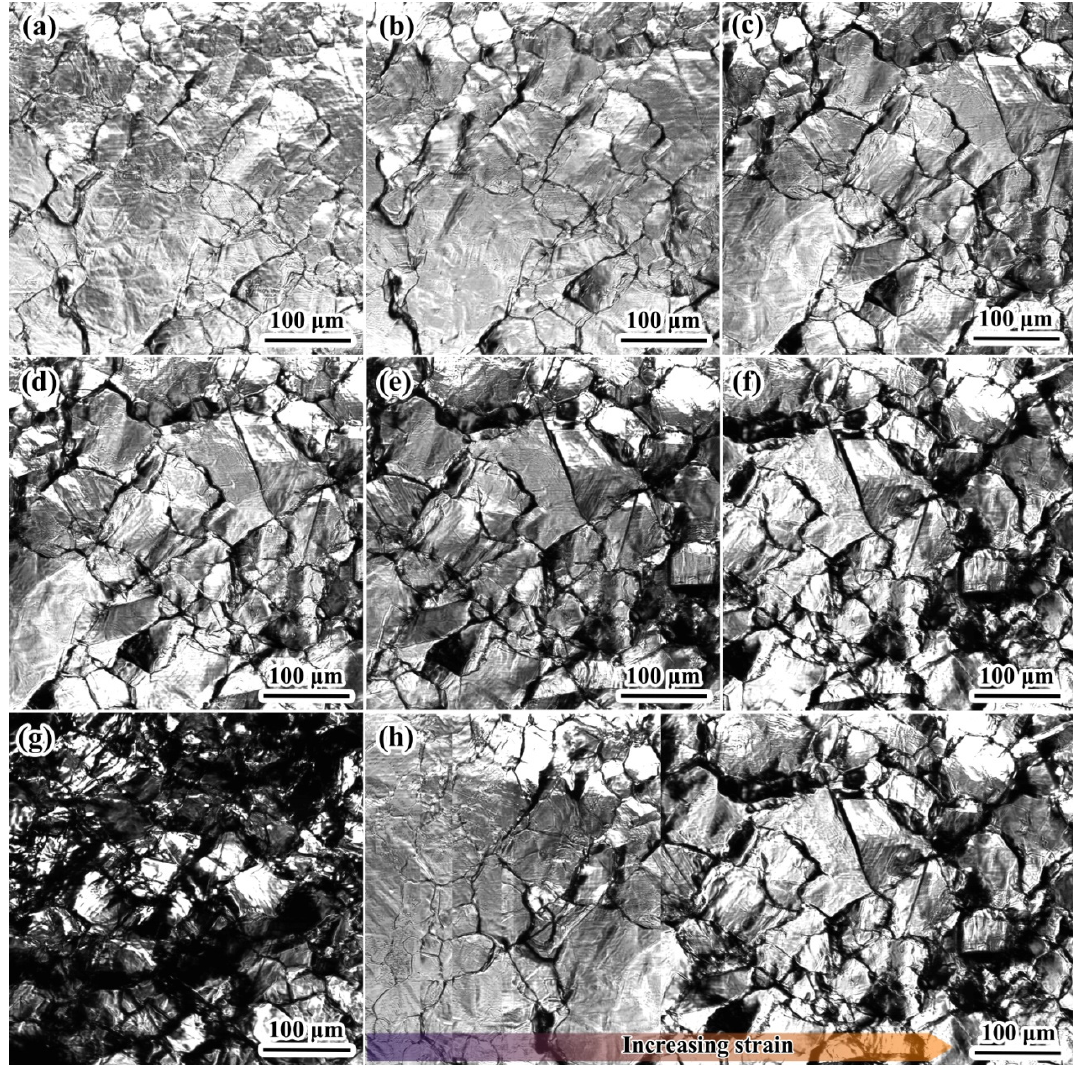
Figure 7. In situ observation results of the microstructure evolutions of 300M steel compressed at the temperature of 1100 ◦ C, at the strain rate of 0.01 s − 1 , and at the strain of ( a ) 0.1, ( b ) 0.2, ( c ) 0.3, ( d ) 0.4, ( e ) 0.5, ( f ) 0.6, and ( g ) 0.9. The merged graph of ( a – f ) was shown in ( h ) to represent the microstructures at various strains.